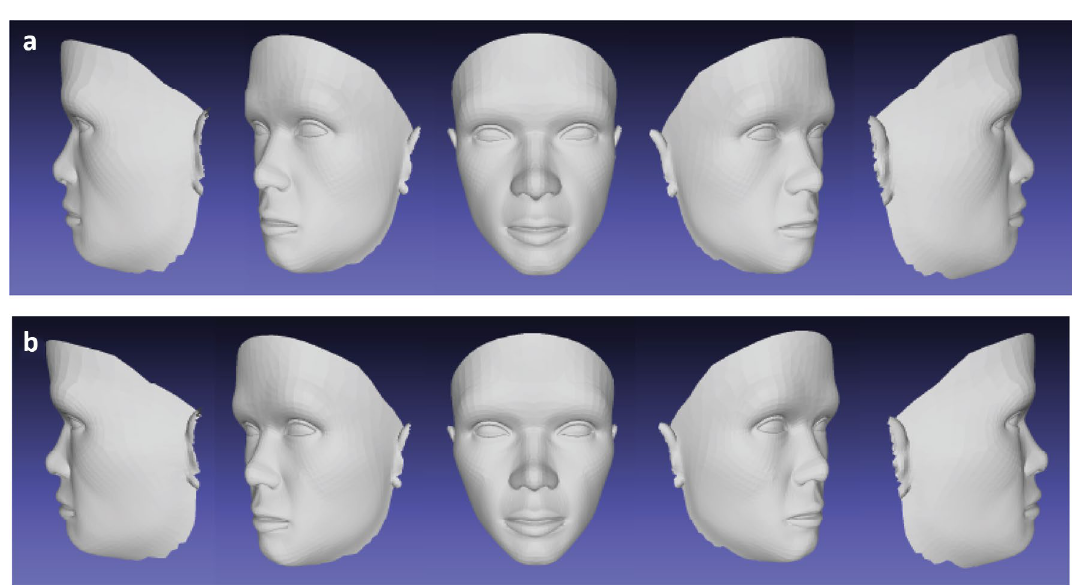
Figure 2. Average faces of 26 subjects generated by Di3DView with 15 and 24 landmark digitation. ( a) Ave_ D15; ( b)